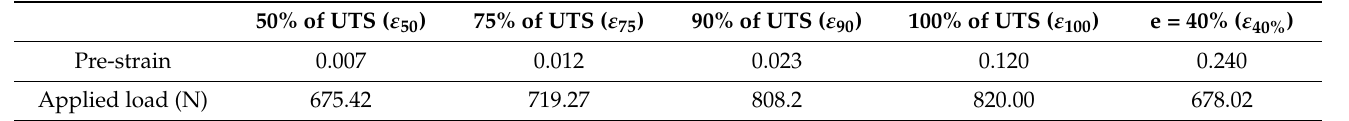
Table 2. The pre-strain value according to the forming load at 250 °C.